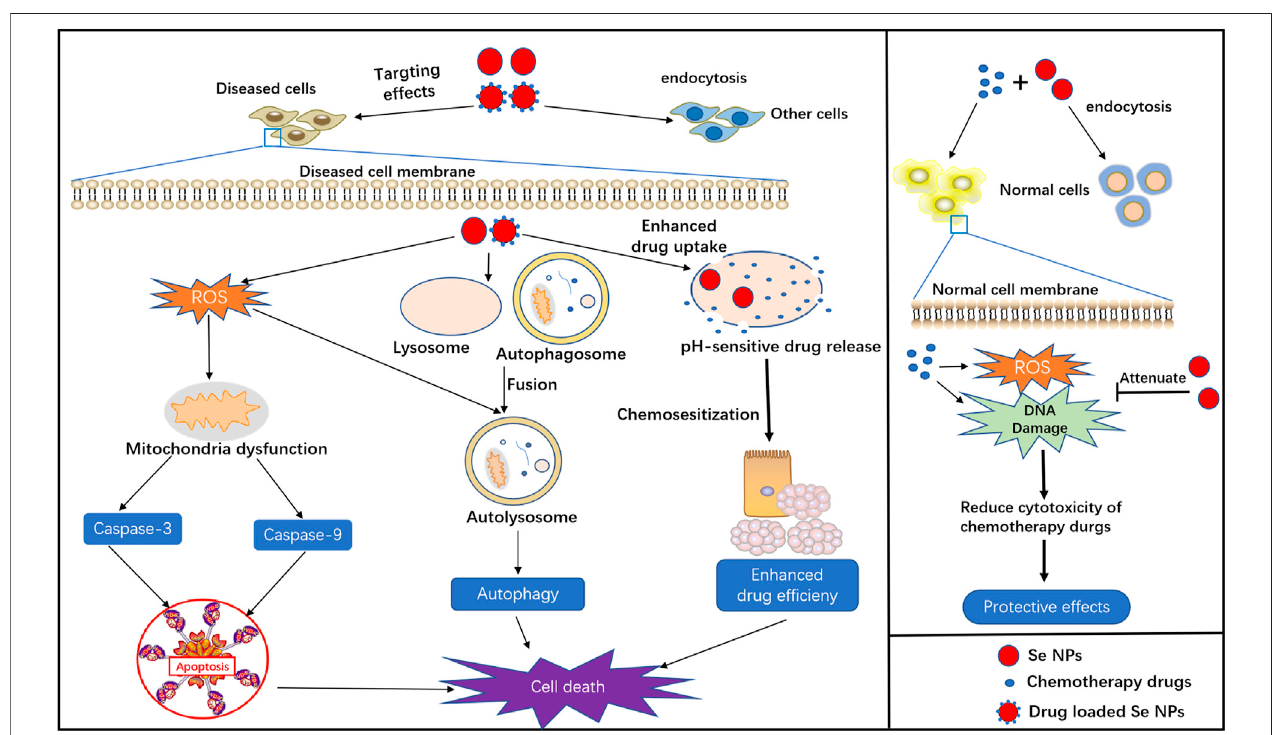
FIGURE 1 | Basic biological functions of Se NPs, including apoptosis and autophagy induction, drug delivery, chemosensitization and protective effects in chemotherapy.